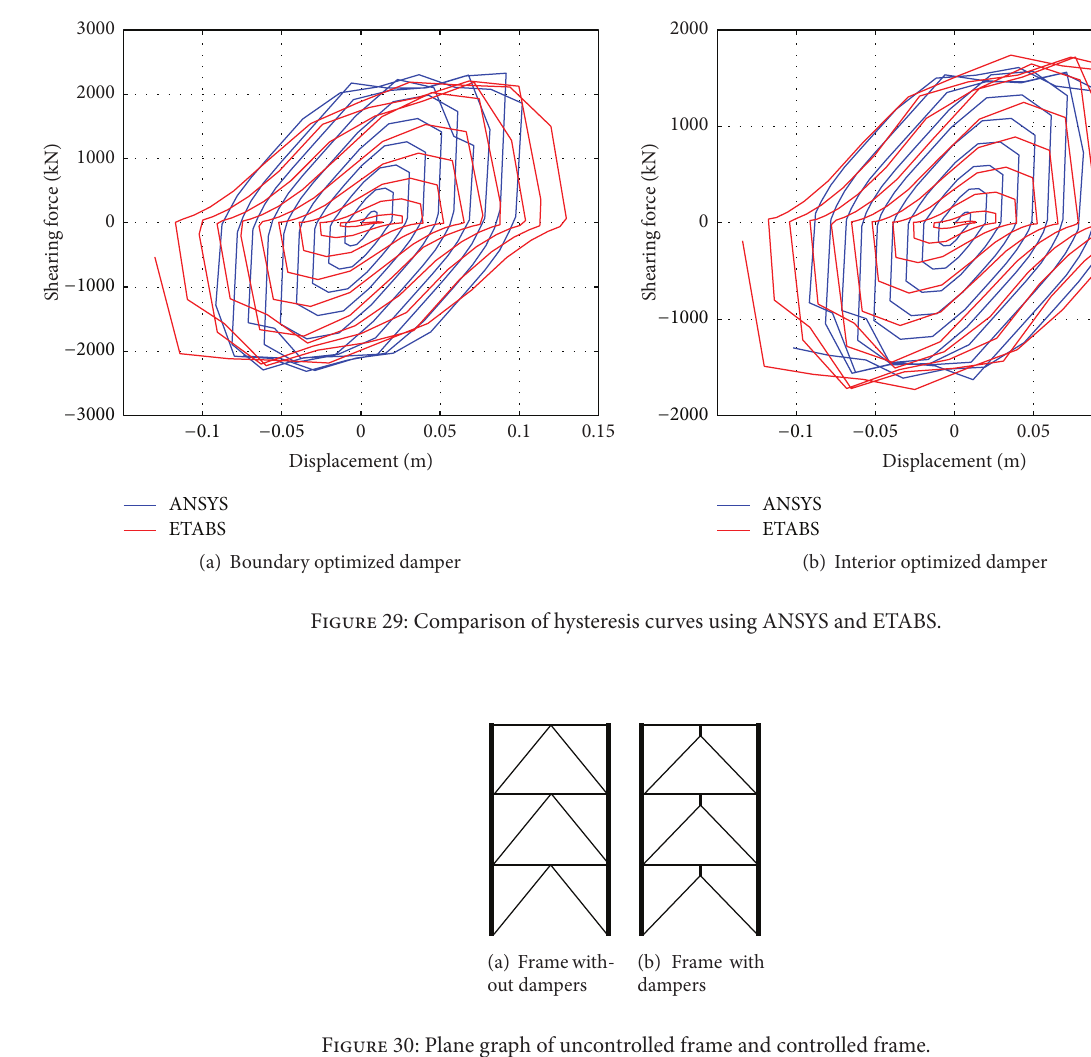
Figure 30: Plane graph of uncontrolled frame and controlled